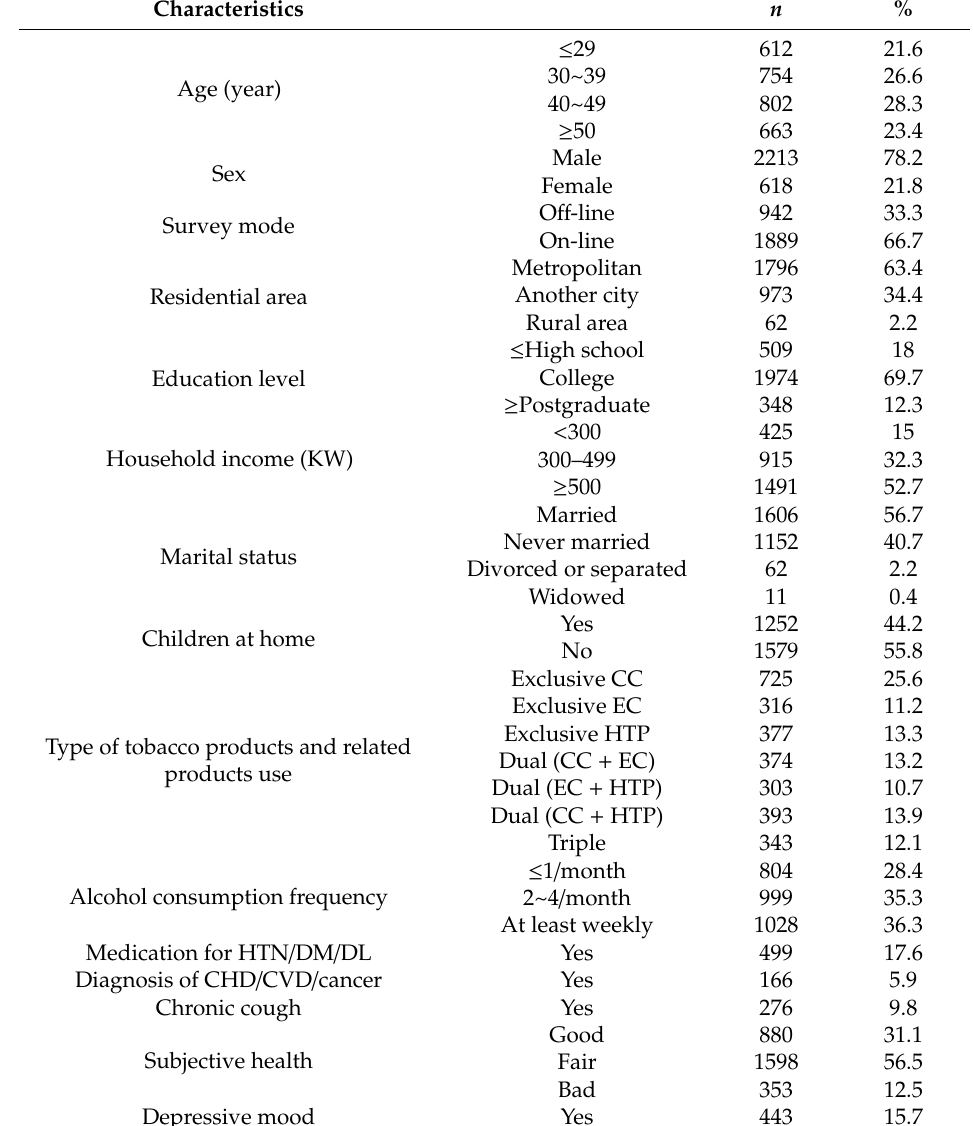
Table 1. General characteristics of study subjects ( n =